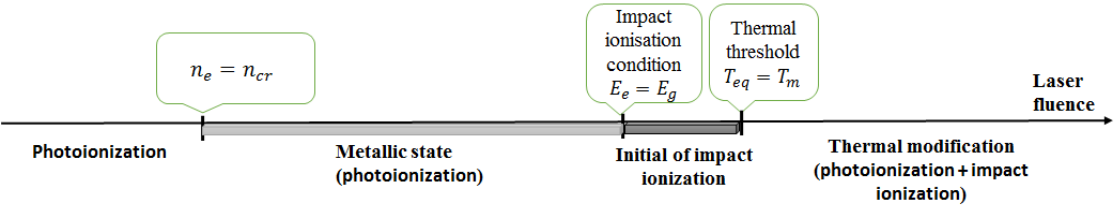
Figure 7. Visual summary of the four stages of Ge modification under fs laser pulses as a function of laser fluence.